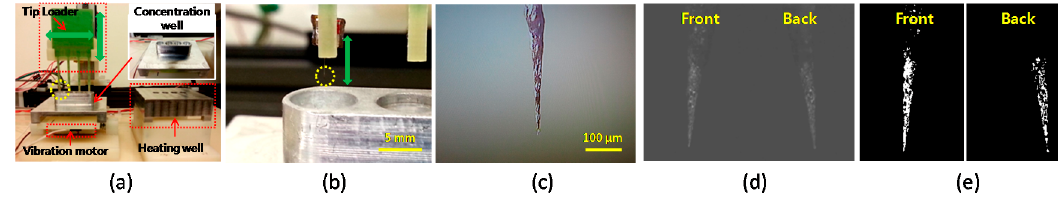
Figure 8. Genomic DNA extraction procedure from cultured cells.